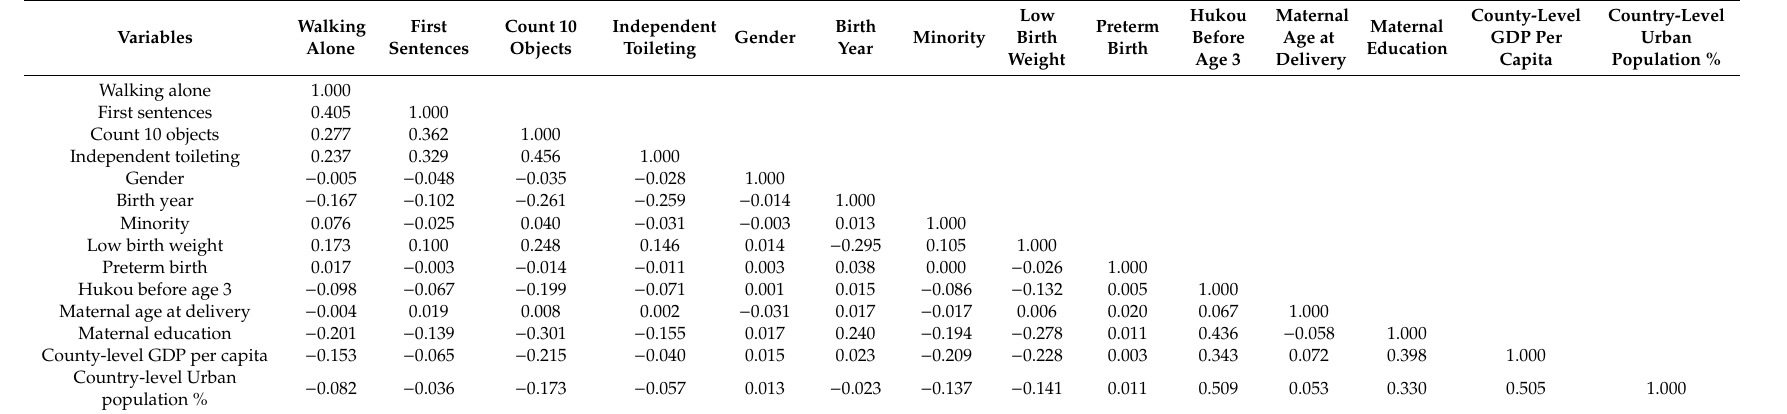
Table A4. Intercorrelations Between County-Level, Family-Level, and Individual-Level Variables Used in the Regression Analyses. Walking First Count 10 Independent Alone Sentences Objects Toileting